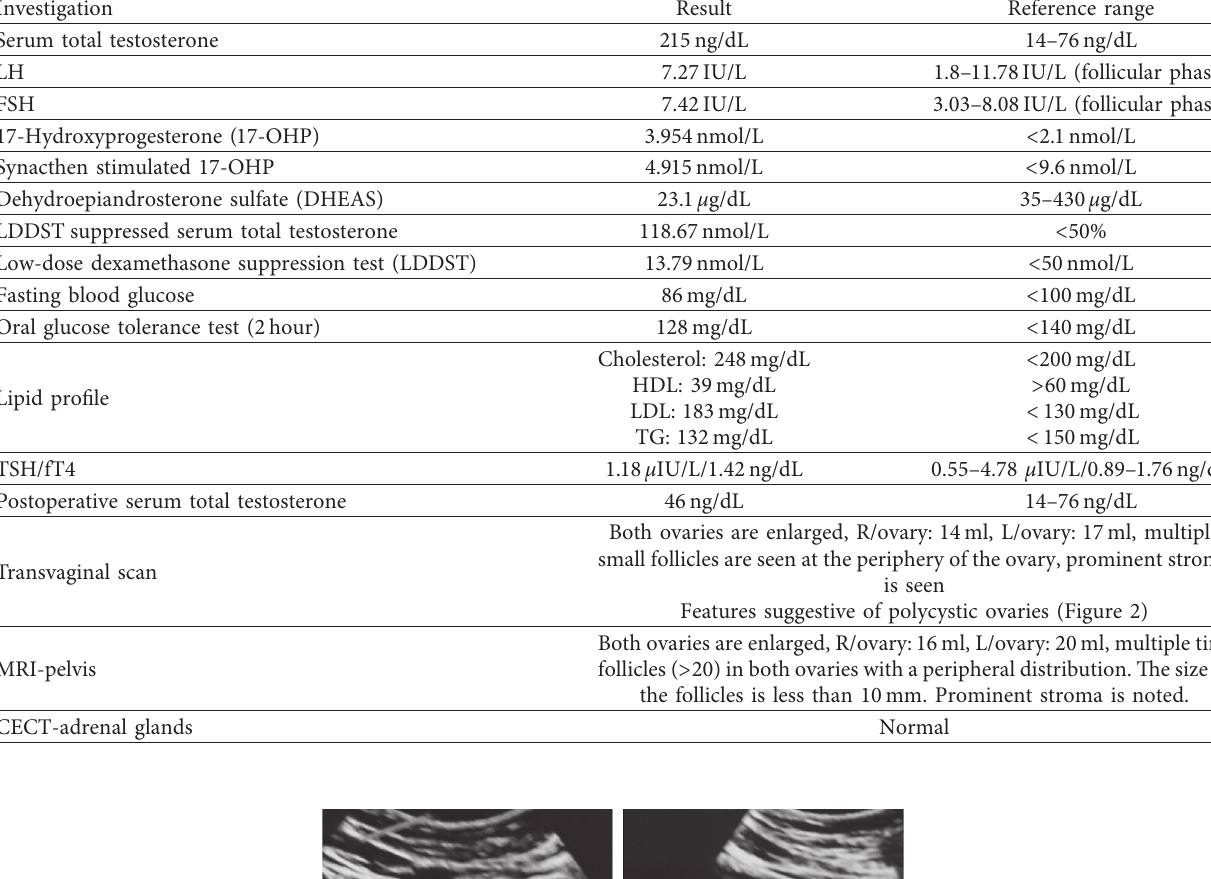
Table 1: Summary of investigations.